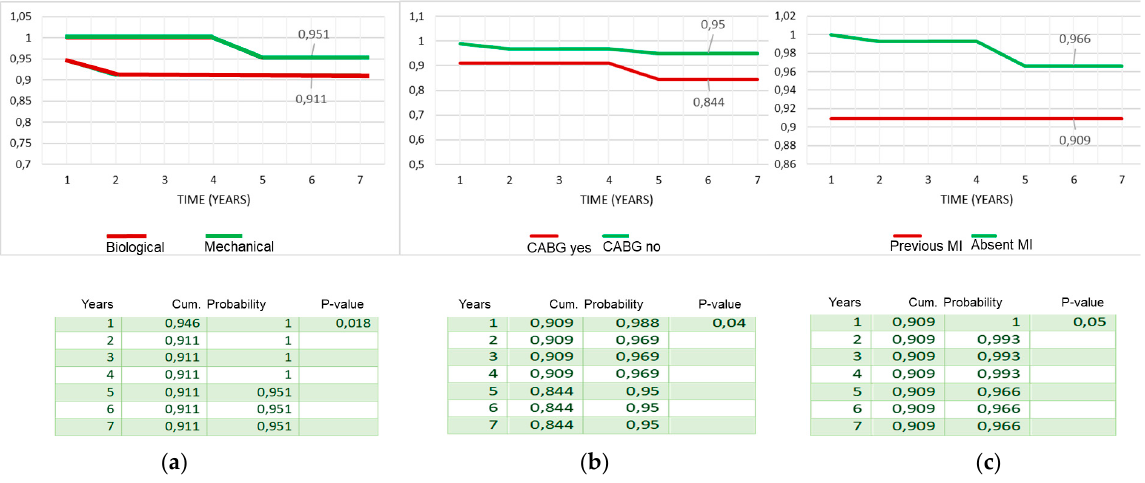
Figure 4. Survival stratified by biological vs. mechanical prostheses ( a ); concomitant CABG ( b ); presence of previous MI ( c ) (log rank, Mantel–Cox test). CABG: coronary artery bypass grafting; MI: